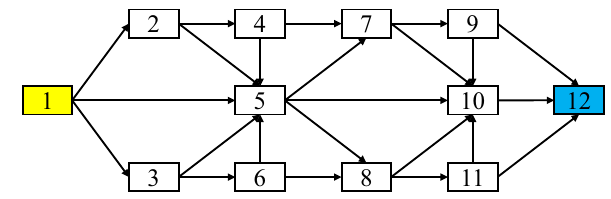
Fig. 12 The directed network for Example 2 Table 5 The crisp and fuzzy weights of the network in Fig. 12 Arc